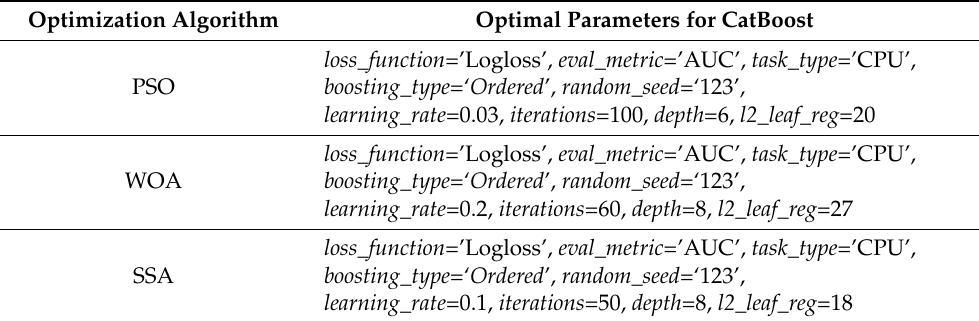
Table 10. Optimal parameters of CatBoost for different optimization algorithms.